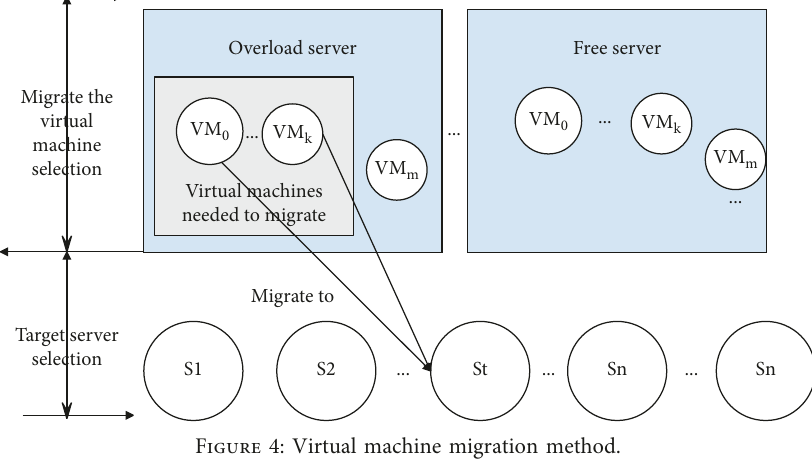
Figure 4: Virtual machine migration method.